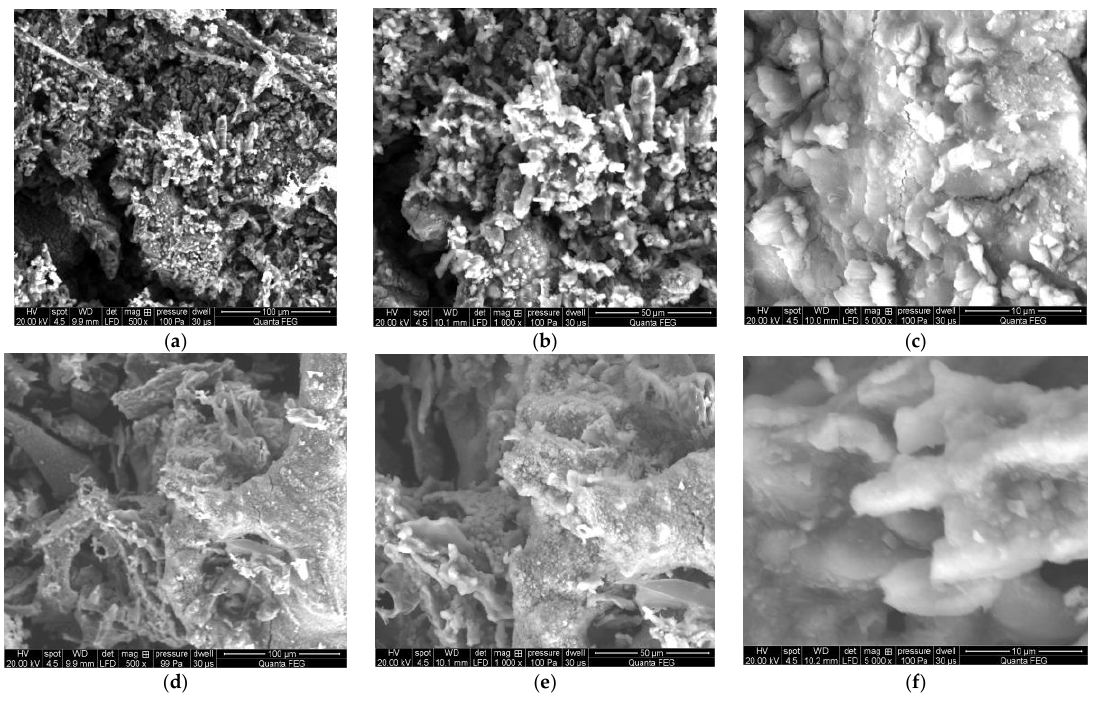
Figure 11. SEM-EDS microscopic images ( a ) 100 µm, ( b ) 50 µm, ( c ) 10 µm of ashes from torrefied Jerusalem artichoke after combustion and ( d ) 100 µm, ( e ) 50 µm, ( f ) 10 µm of ashes from untreated Jerusalem artichoke after combustion.